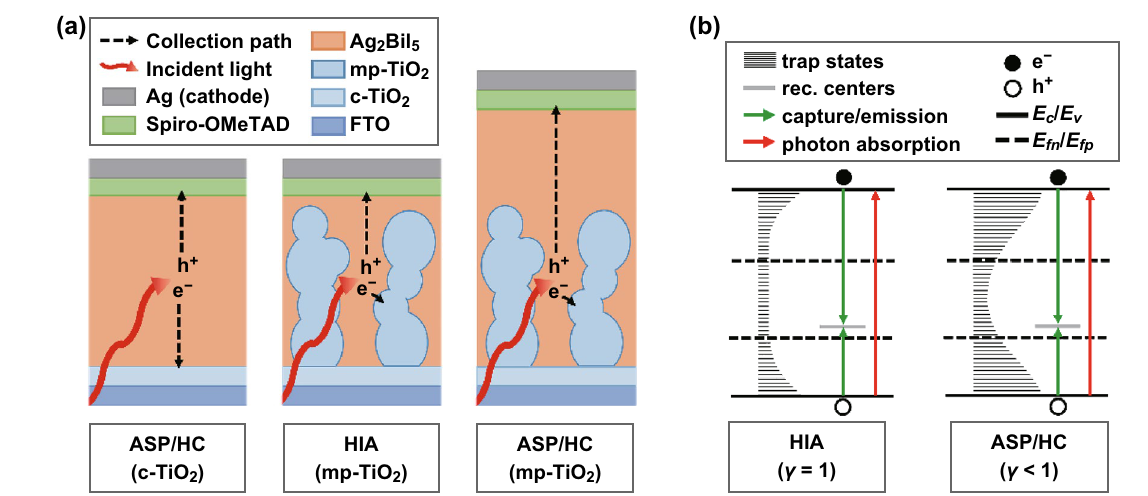
Fig. 4 a Schematic of absorption and carrier collection in different Ag 2 BiI 5 layers. b One‑center models consistent with the optoelectronic char‑ acterization of the Ag 2 BiI 5 layers presented in the